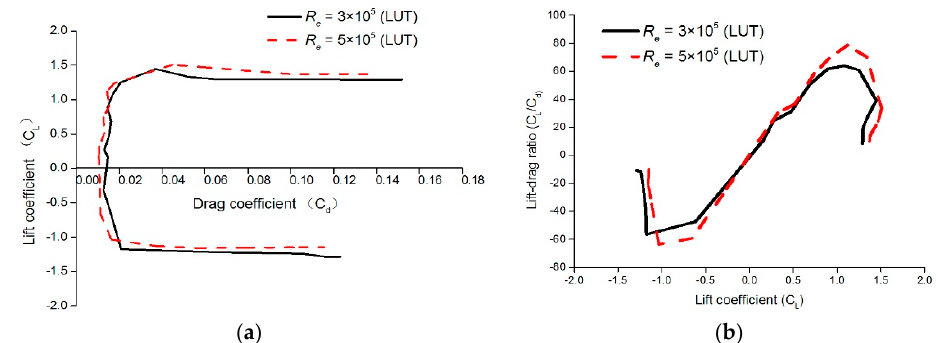
Figure 11. The characteristics of lift–drag ratios for the LUT airfoil at different values of R e : ( a ) the relationship between the lift coefficient and the drag coefficient; and ( b ) the relationship between lift–drag ratios and the lift coefficient. The lines in black and red of the lift–drag ratios correspond to R e = 3 × 10 5 and R e = 5 × 10 5 , respectively.